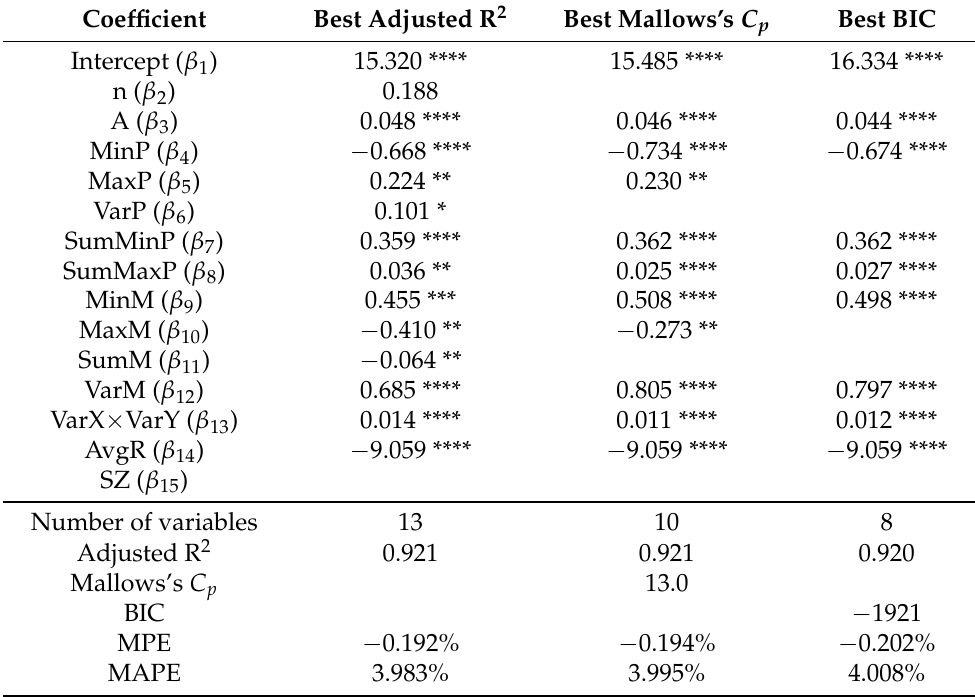
Table 5. Regression results on the three selected best subset